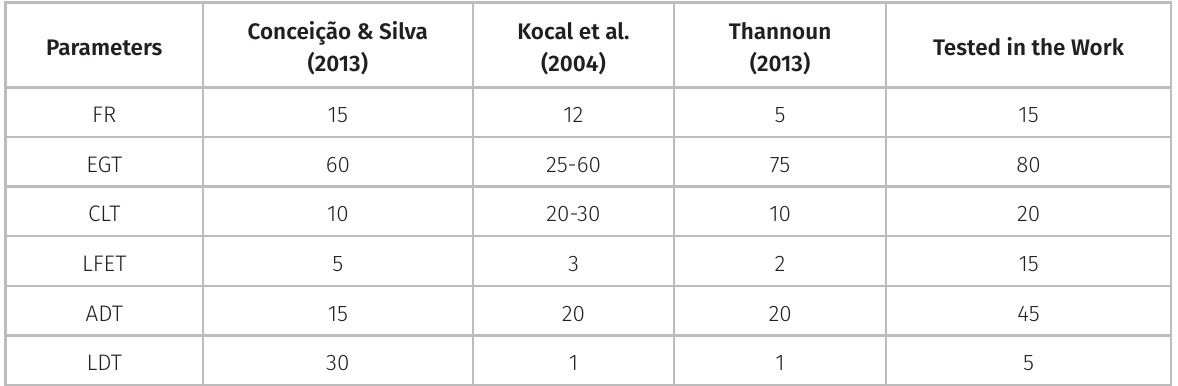
Table II. The input parameters used as reference and the one tested in this research.